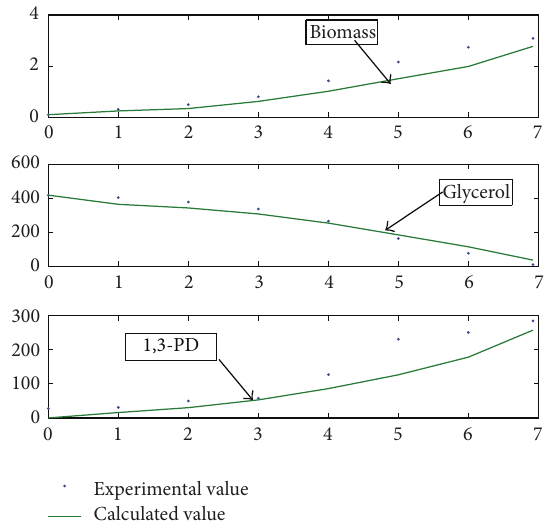
Figure 2: Comparison of extracellular concentration between computational results and the experimental